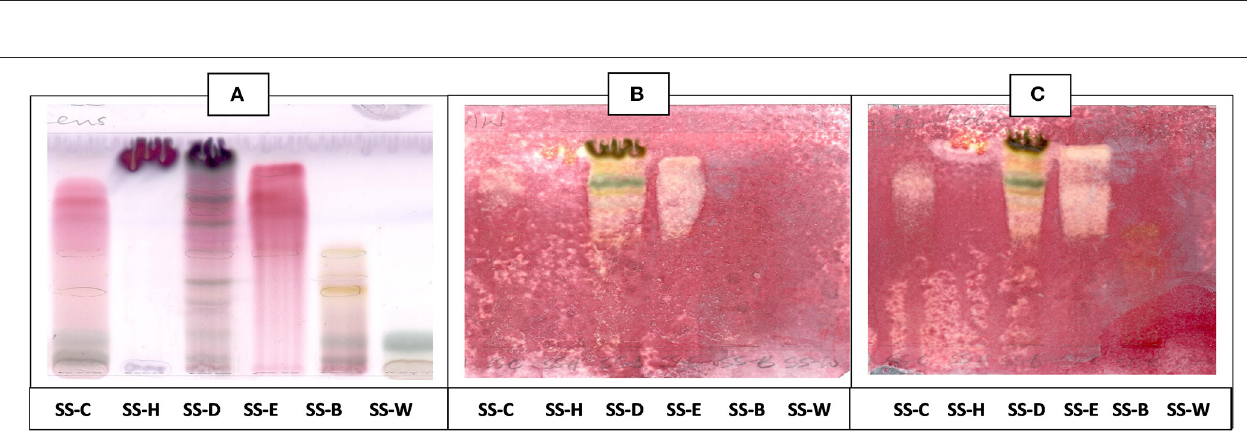
FIGURE 4 | (A) Chromatogram developed in EMW [ethyl acetate: methanol: water (40:5.4:4)] of S. singueana fractions sprayed with vanillin. (B) Bioautography of S. aureus –TLC plate developed with EMW (40:5.4:4). (C) Bioautography of S. Enteritidis –TLC plate developed with EMW (40:5.4:4). SS-C, S. singueana crude extract; SS-H, hexane fraction; SS-D, dichloromethane fraction; SS-E, ethyl acetate fraction; SS-B, butanol fraction; SS-W, Water fraction. White bands indicate compounds that inhibit bacteria.